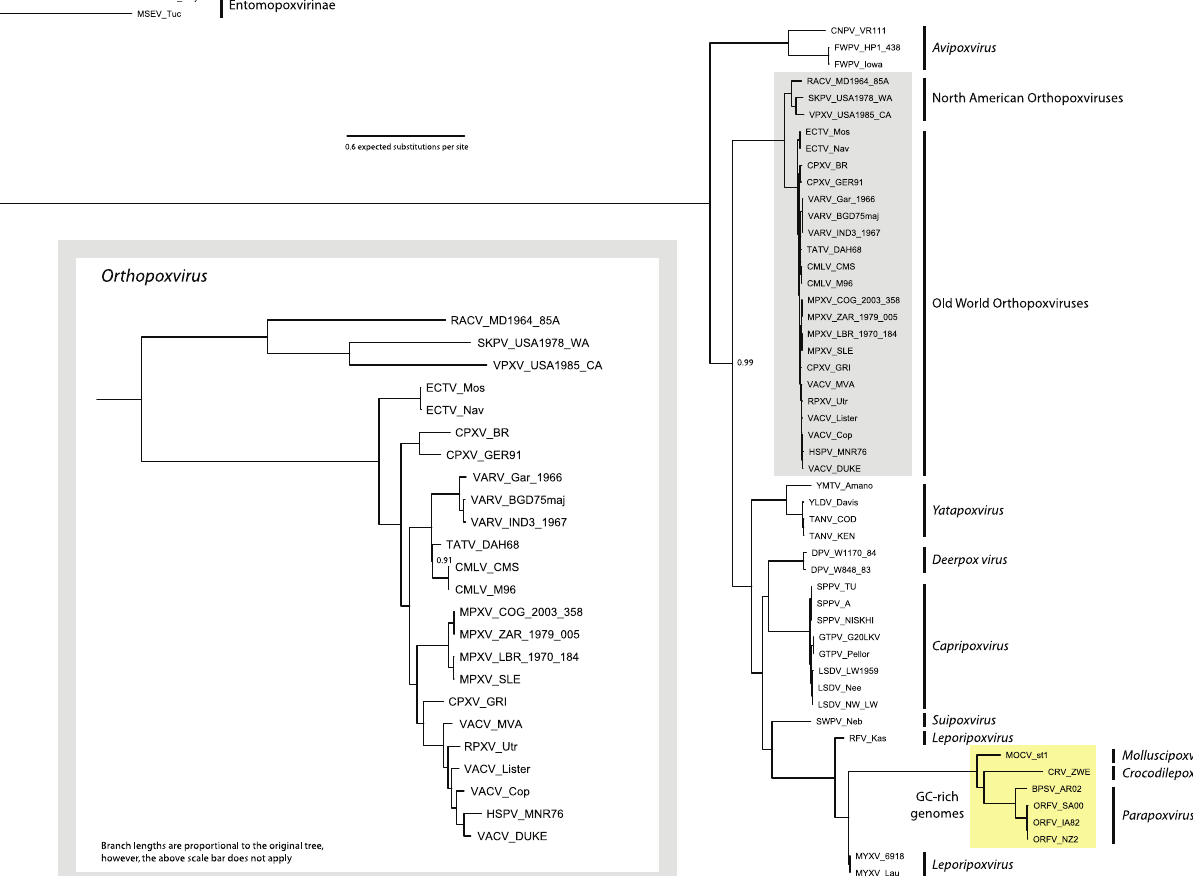
Figure 1. Poxvirus phylogenetic tree inferred from Bayesian analysis of the DNA sequences from 9 conserved genes. Four Metropolis- coupled Markov chain Monte Carlo simulations using the general time reversible (GTR) + c + I model were run over 5 million generations, with trees and parameters being sampled every 100 generations. The consensus tree was derived from 30,000 of the trees sampled. All but 2 nodes had posterior probabilities of 1.00; these two nodes are labeled in the figure. A close-up of the Orthopoxvirus lineage is presented in the inset. GC-rich genomes are indicated by the yellow box.